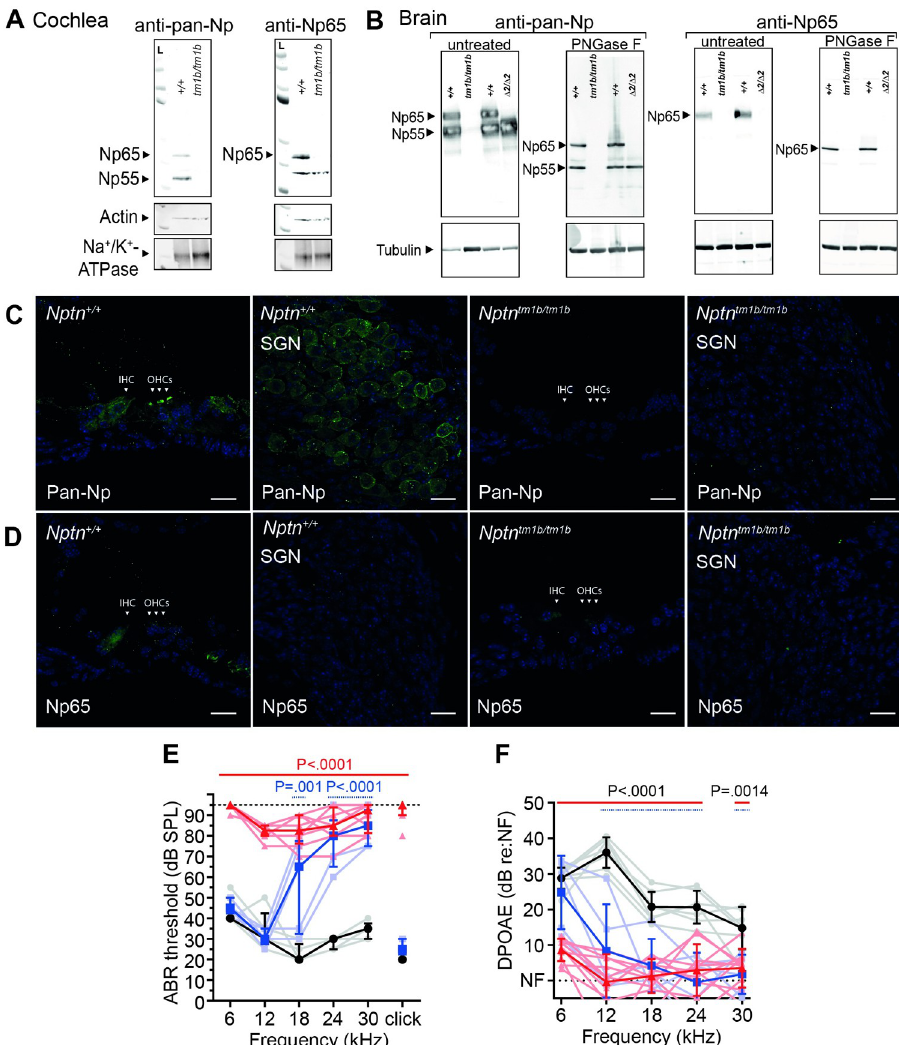
Fig 2. Np65 and Np55 are cochlear expressed. (A) Western blot of membrane-enriched fractions prepared from Nptn +/+ and Nptn tm1b/tm1b cochleae. Lysates were treated with PNGase F to remove N-linked glycans before separation. In the wild type membrane fraction, the anti-pan-Np antibody detects bands corresponding to native Np65 (44.4 kDa) and Np55 (31.3 kDa), whereas the anti-Np65-specific antibody detects only a single band corresponding to Np65. No specific bands were detected in the membrane fraction prepared from Nptn tm1b/tm1b cochleae using either antibody. Na + /K + -ATPase was used as a marker protein for the plasma membrane. (B) Whole brain protein lysates prepared from Nptn tm1b/tm1b ( tm1b/tm1b ), Nptn Δ exon2/ Δ exon2 ( Δ 2/ Δ 2 ) and their respective wild type controls, were separated by PAGE and Western blotted utilizing an anti-pan-Np antibody and an anti-Np65 antibody. For wild type lysates, both Np55 and Np65 are detected. However, neither protein isoform was detected in Nptn tm1b/tm1b lysates. Importantly, only Np55 was detected in Nptn Δ exon2/ Δ exon2 lysates, confirming the absence of Np65. Western blots were run using native (untreated) and deglycosylated (PNGase F) lysates. Tubulin is used as a loading control. (C) Cochlear immunohistochemistry of cryosections using the anti-pan-Np antibody showed labelling of outer hair cell (OHC) stereocilia, inner hair cells (IHC), support cells lateral to the hair cells, and the spiral ganglion neurons (SGN). No signal was observed in Nptn tm1b/tm1b cochlea. Scale = 20 μ m. (D) The anti-Np65 specific antibody showed labelling of IHCs and support cells lateral to the hair cells. No signal was observed in Nptn tm1b/tm1b cochleae. Scale = 20 μ m. (E) ABR threshold measures recorded from 1-month old mice showing profoundly elevated thresholds for all stimuli tested in Nptn tm1b/tm1b mice (red triangles, n = 8) compared to wild type littermates (black circle, n = 5). Heterozygous Nptn +/tm1b mice (blue squares, n = 5) exhibit a significant high frequency ( � 12 kHz) hearing loss compared to control littermates. Data shown as median ± I.Q.R with individual data points. One-way ANOVA comparing to wild type, employing Dunnett’s test for multiple comparisons. (F) Average DPOAE responses recorded from 1-month old mice. Both Nptn tm1b/tm1b (n = 10) and Nptn +/tm1b (n = 5) mice have suppressed response amplitudes compared to littermate controls (n = 7). Data are mean ± SD with individual data points shown. One-way ANOVA comparing to wild type controls, employing Dunnett’s test for multiple